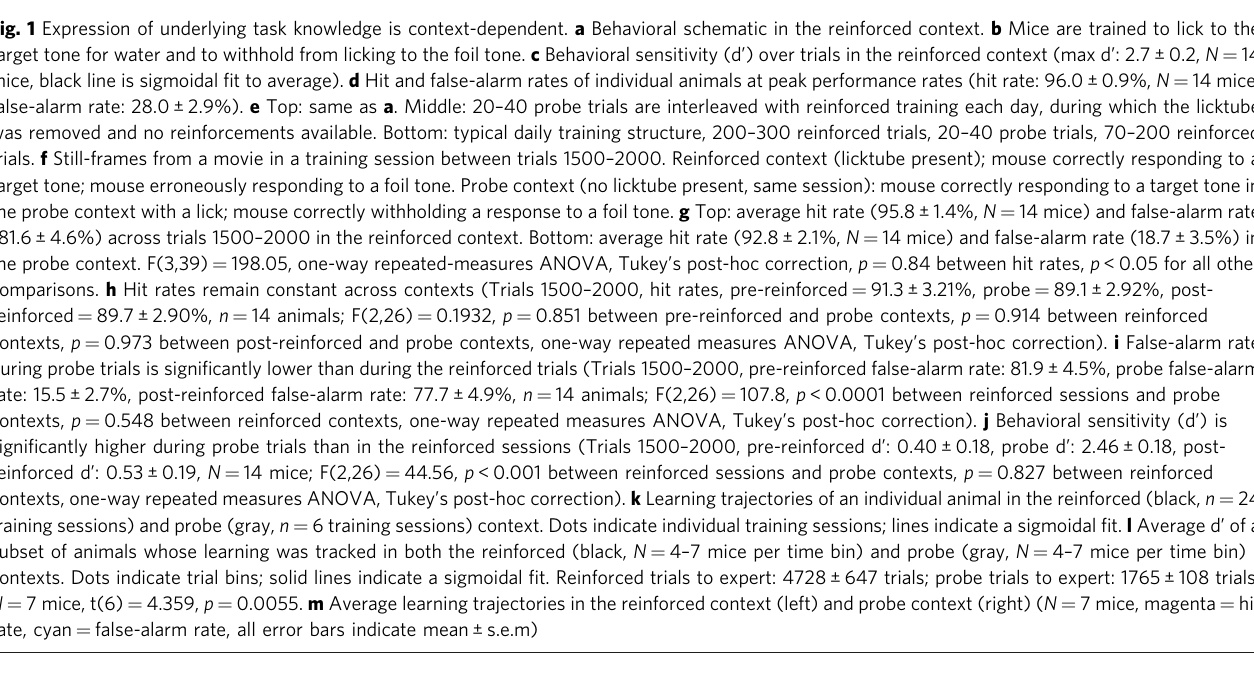
(Supplementary Movie 5; Supplementary Fig. 1c, hit rate = 86.5